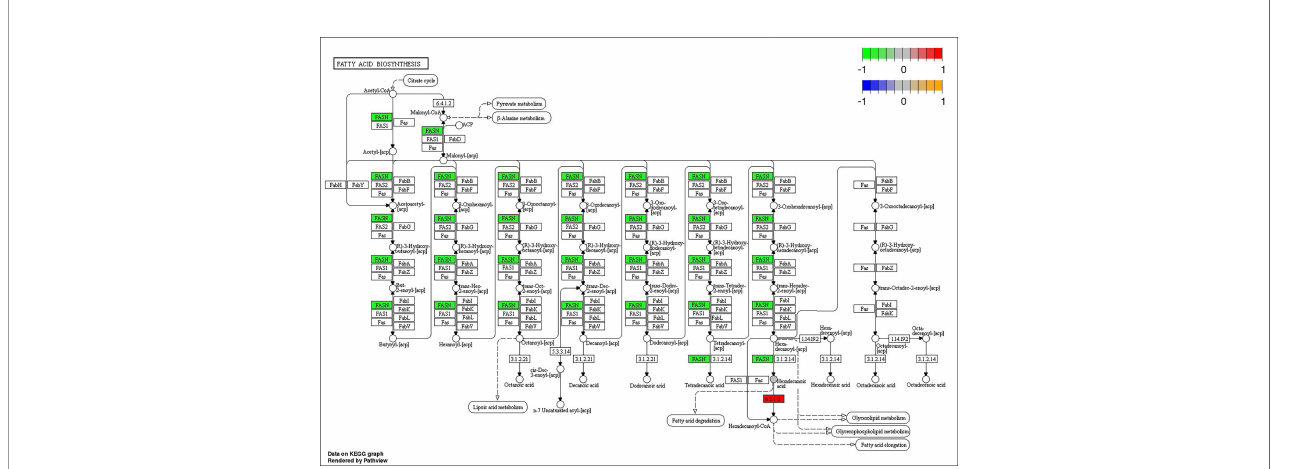
FIGURE 5 | Changes in the fatty acid biosynthesis pathway in Ctenopharyngodon idella brain after 2-phenoxyethanol (2-PE) high-concentration treatment.